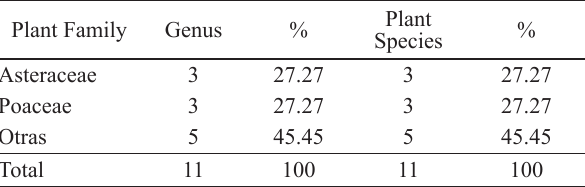
Table 4 . Families with the highest number of genera and